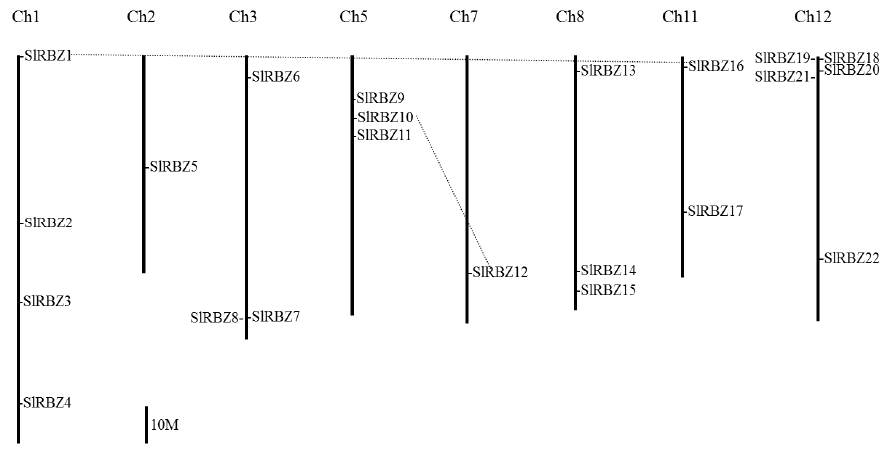
Figure 3. Chromosomal location of SlRBZ genes. The gene pairs are linked by dashed lines.